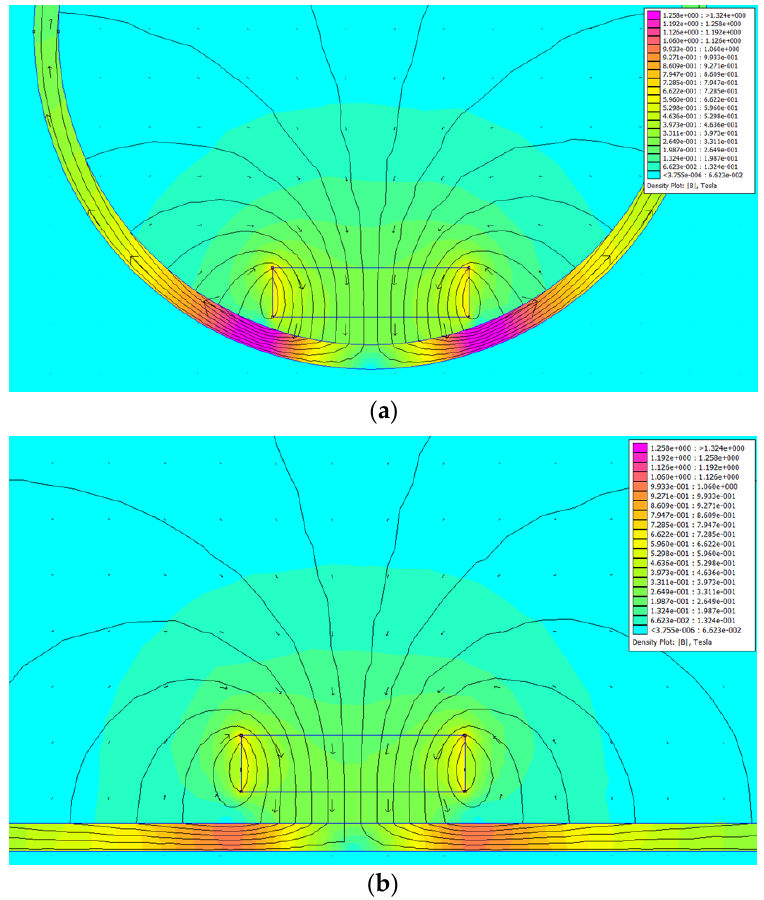
Figure 6. The 2D simulation results of the magnetic flux distribution: ( a ) The magnet in the ferromagnetic pipe; ( b ) the magnet on the ferromagnetic flat plate.